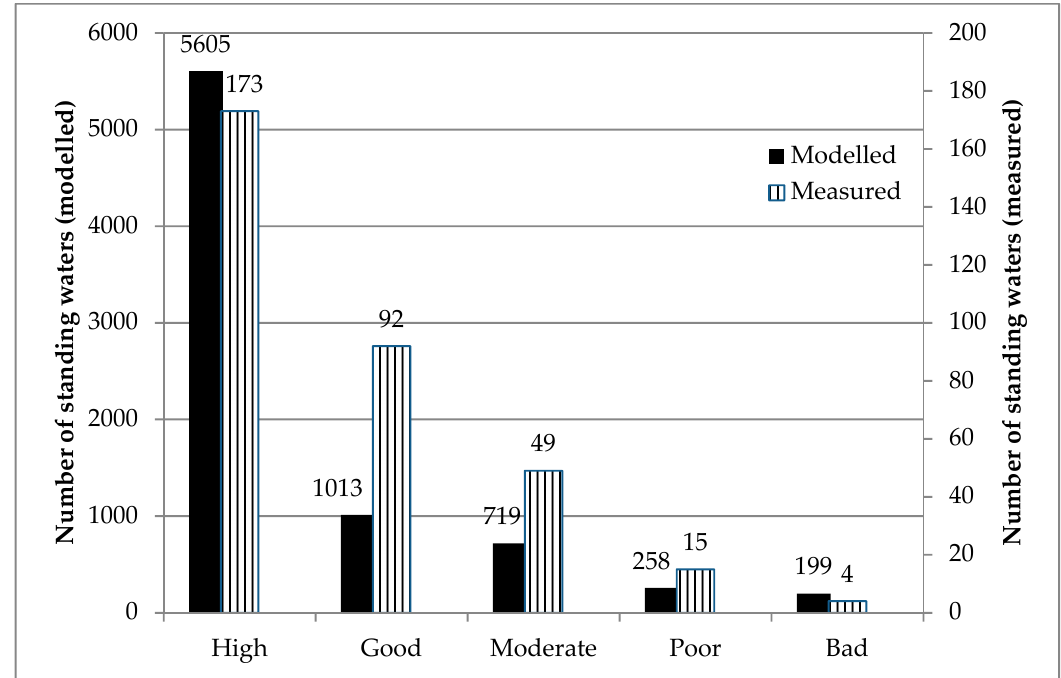
Figure 6. WFD status of 7794 modelled standing waters and 333 measured standing waters (Note that, due to data limitations, not all standing waters for which concentrations are calculated will have a WFD status, and that although the table shows all 333 SEPA reported classifications, only 323 of these can be modelled in PLUS+).